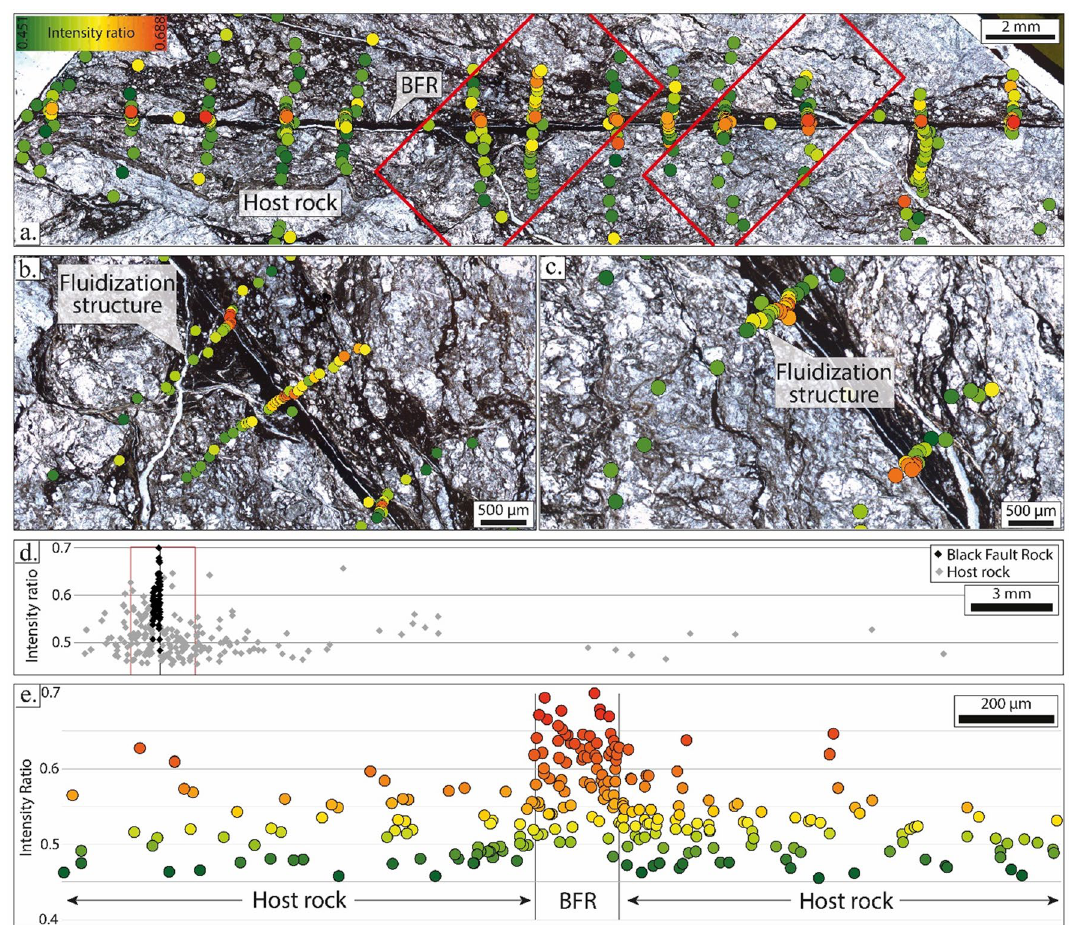
Figure 4. Raman spectroscopy results obtained for the Okitsu Black Fault Rock and its host rock. ( a ) Intensity ratio evolution along high-resolution cross-sections of the Black Fault Rock; ( b , c ) Close-up views of the fault core and the fluidization structure. ( d ) Integrated cross-section showing RSCM intensity ratio evolution. ( e ) Close-up view (red square in (d)) which shows the sharp evolution of the RSCM intensity ratio near the fault core. RSCM Raman Spectroscopy of Carbonaceous